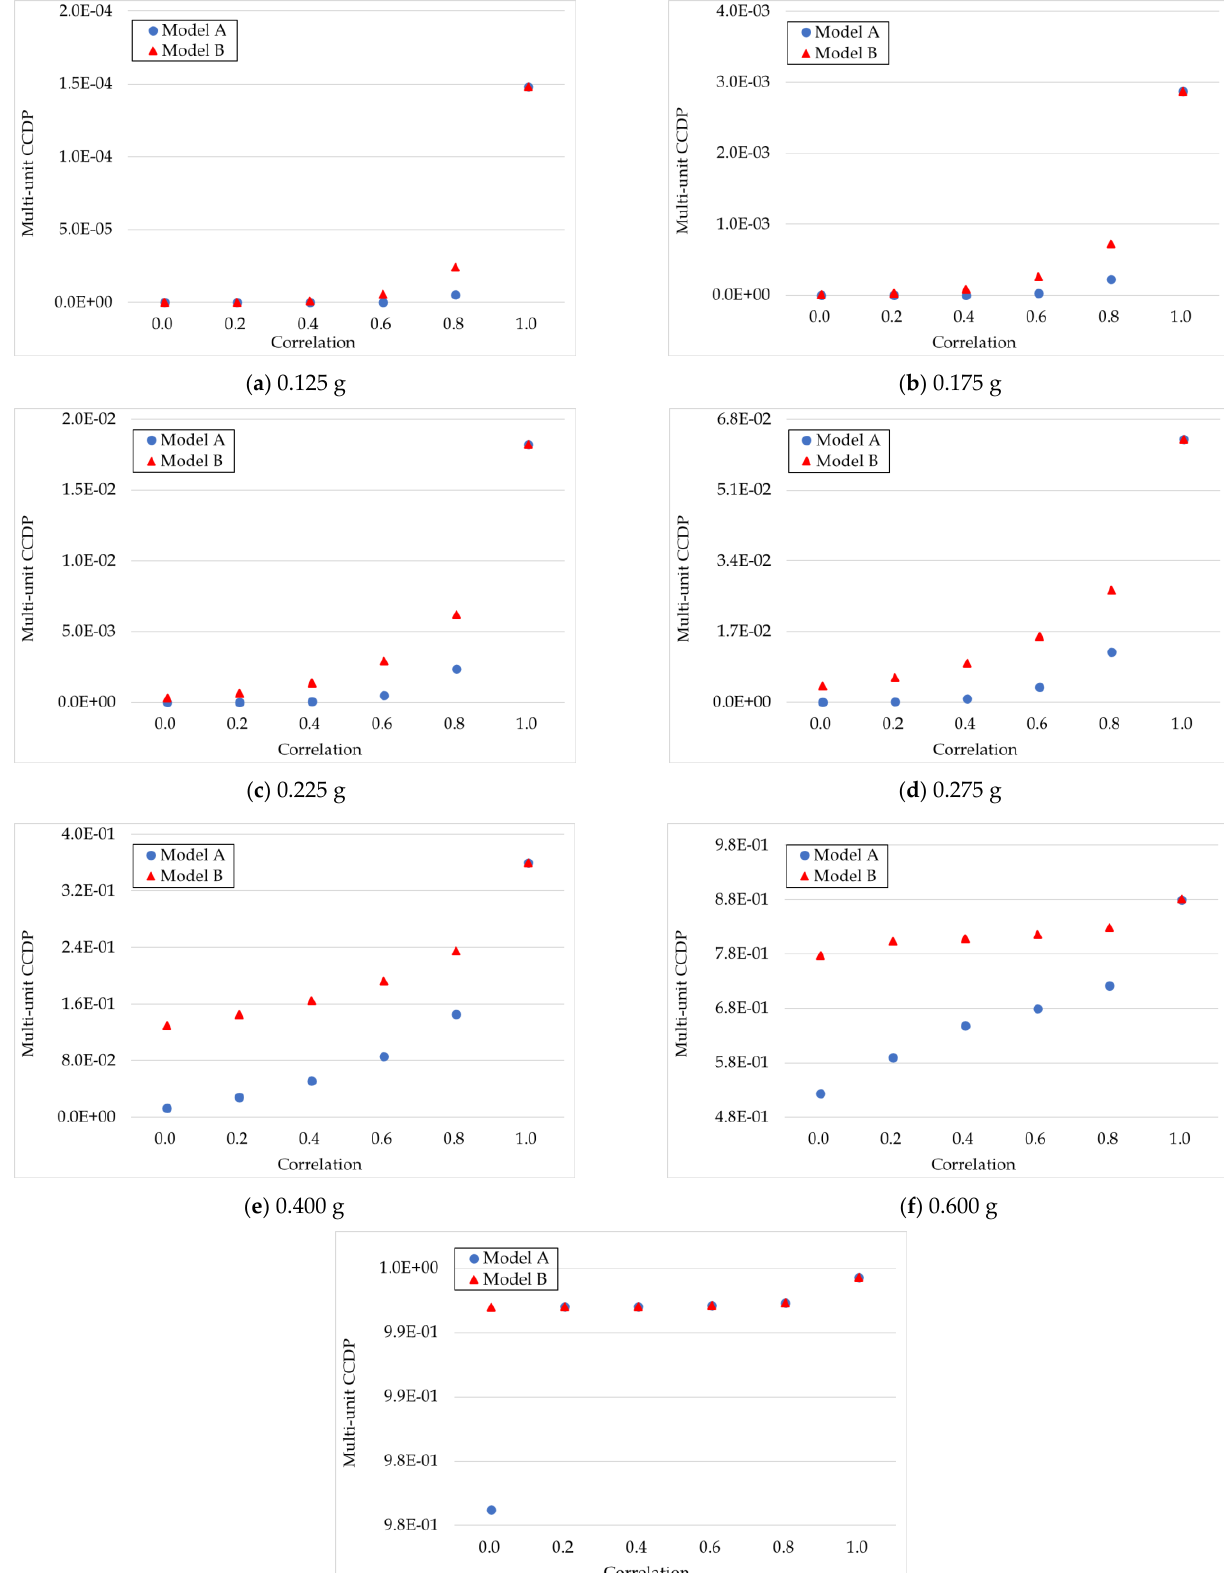
Figure 15. Plots of MUCCDP versus seismic correlation.